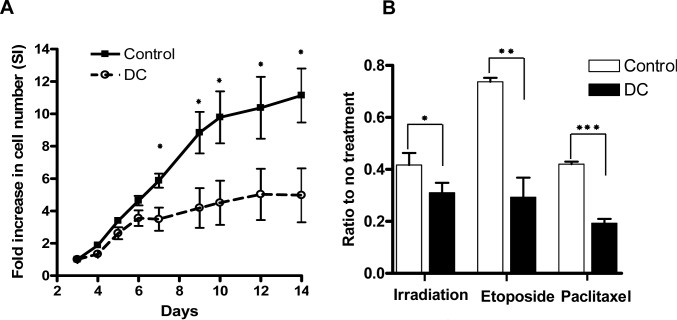
Impaired growth of DC lymphocytes in cell culture.(A) Control (n = 5) and DC (n = 5) lymphocytes were stimulated with CD3/CD28 beads at day 1 and cultured in IL-2 supplemented medium. The stimulation index (SI) is calculated as a fold increase in cell number relative to the starting cell number. Statistically significant difference in proliferation of DC versus control lymphocytes was noted starting from day 7 (*p<0.01). (B) Increased growth sensitivity of DC lymphocytes to irradiation (XRT) and chemotherapy. Control (n = 4) and DC (n = 5) cells were treated with XRT (5 Gy) and proliferation was assessed two days later. Alternatively cells were treated with Etoposide (10−5 M) or Paclitaxel (10−6 M) for four days and assessment of cell growth was done two days after treatment. Data is presented as a ratio of cell numbers in treated versus their respective untreated culture controls. A statistically significant decrease in DC cell growth compared to controls was determined after XRT (*p<0.05), or after treatment with Etoposide (**p<0.01) and Paclitaxel (***p<0.0005).